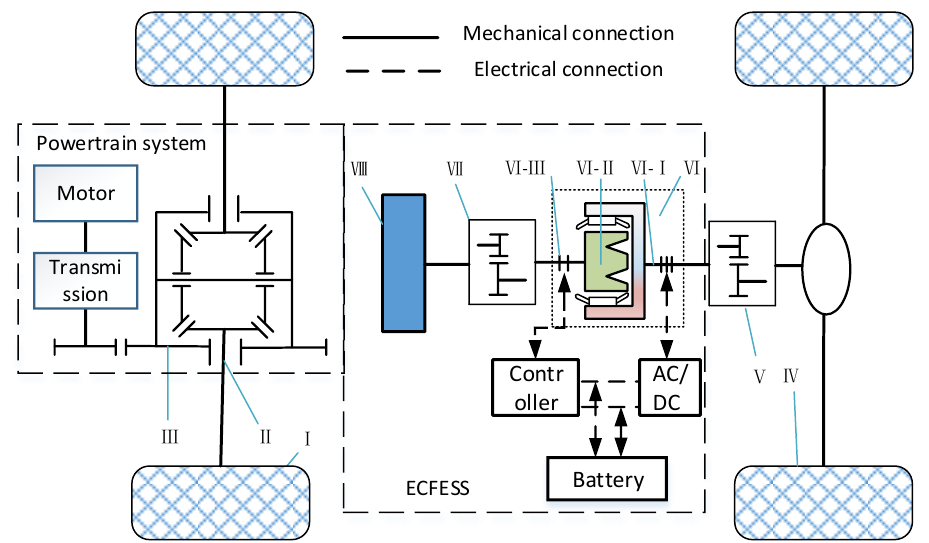
Figure 2. Electromagnetic coupling flywheel energy storage system (ECFESS)-based powertrain train system. I—front wheel; II—half-shaft; III—final drive; IV—rear wheel; V—first gear pair; system. I — front wheel; II — half-shaft; III — final drive; IV — rear wheel; V — first gear pair; VI—electromagnetic coupler; VI-I—armature shaft (mechanical port); VI-II—magnetic shaft (mechan- VI — electromagnetic coupler; VI-I — armature shaft (mechanical port); VI-II — magnetic shaft (me- ical port); VI-III—electrical port; VII—second gear pair; chanical port); VI-III — electrical port; VII — second gear pair; VIII — flywheel.